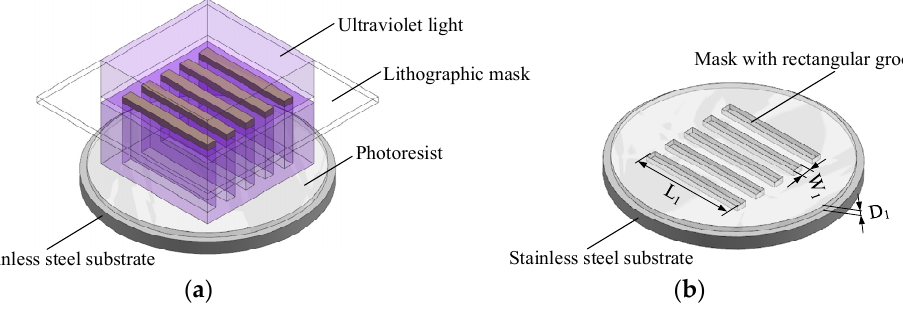
Figure 1. Schematics of key processes during preparation of mask with rectangular grooves: ( a ) exposure; ( b ) development.